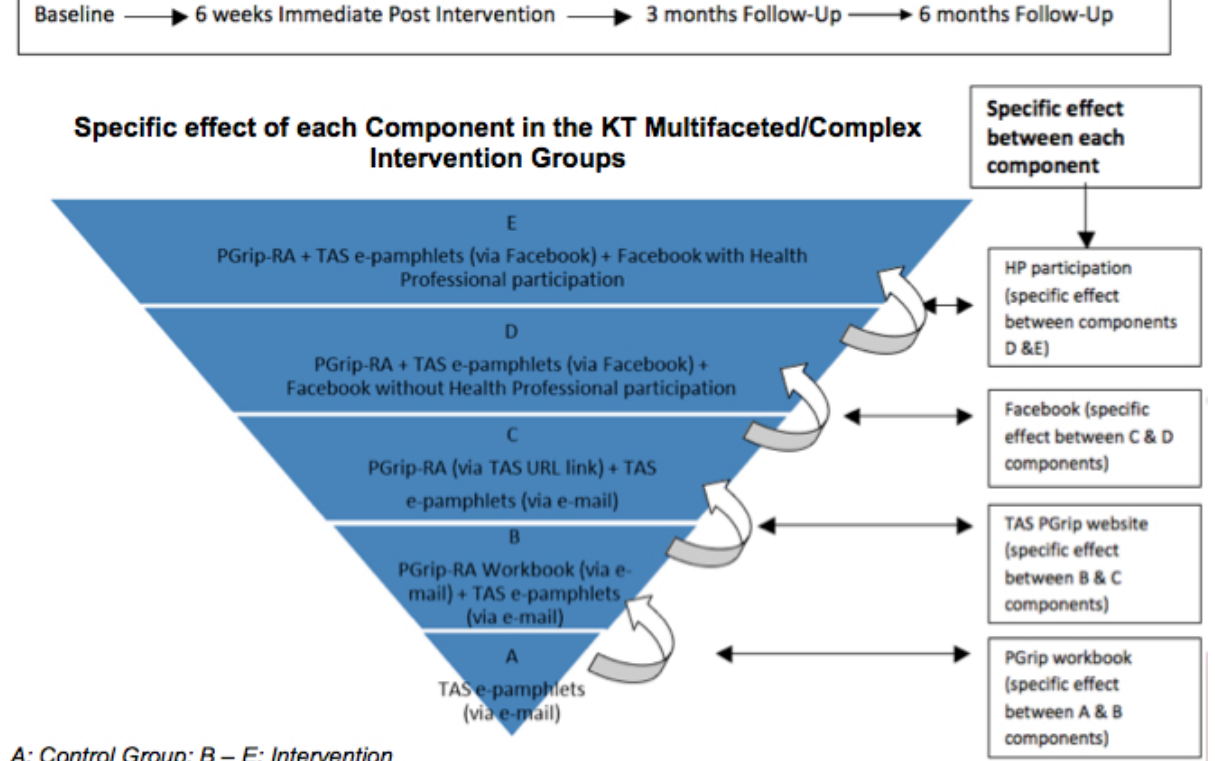
Figure 3. Specific effect of each component in the Knowledge Translation multifaceted/complex intervention